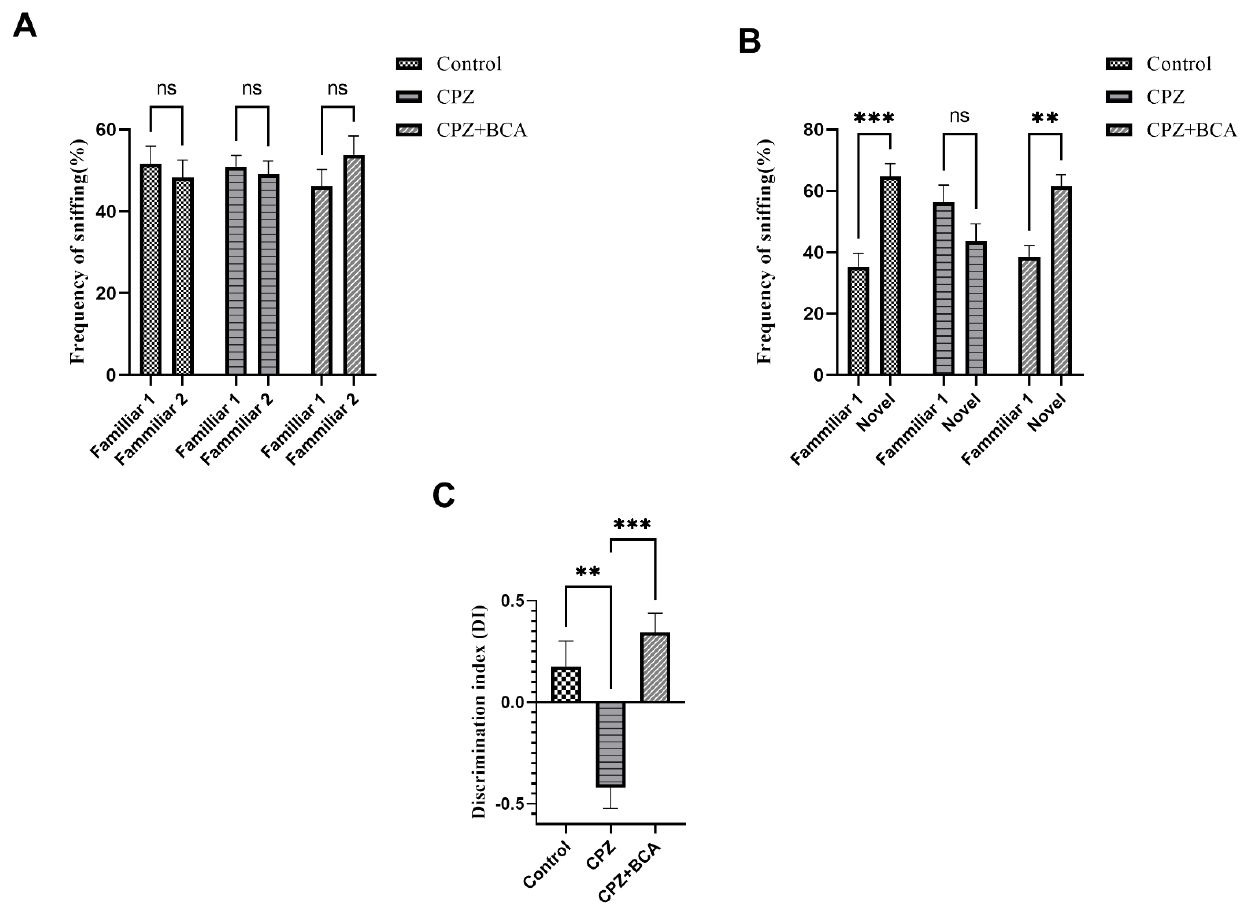
Figure 4. Novel object recognition test (NORT). ( A ) frequency of sniffing (%) during familiarization phase. No significant difference in each group in sniffing each of the familiar objects. ( B ) frequency of sniffing (%) during test phase. Mice in the control group and the BCA group had a significant increase in the frequency of sniffing for the novel object while there was no significant difference in the CPZ group for the frequency of sniffing in the test phase ( C ) DI. CPZ group showed a significant decrease in the DI compared with the control group. BCA significantly improved the DI compared with the CPZ group. Data are presented as mean ± SEM. Two-way ANOVA followed by the Bonferroni multiple comparisons test ( A , B ) and one-way ANOVA followed by the Tukey multiple comparisons test ( C ) were used. ns = non-significant, ** p < 0.01, *** p < 0.001. DI: discrimination index. (CPZ: cuprizone; BCA: biochanin A).